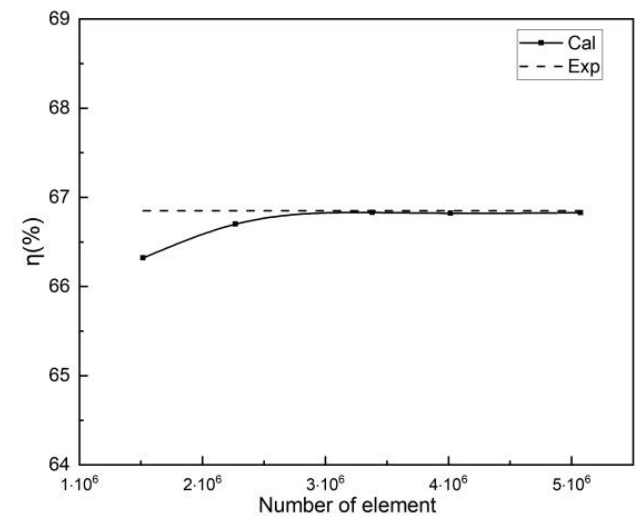
Figure 4. Grid-independence validation of the current study.